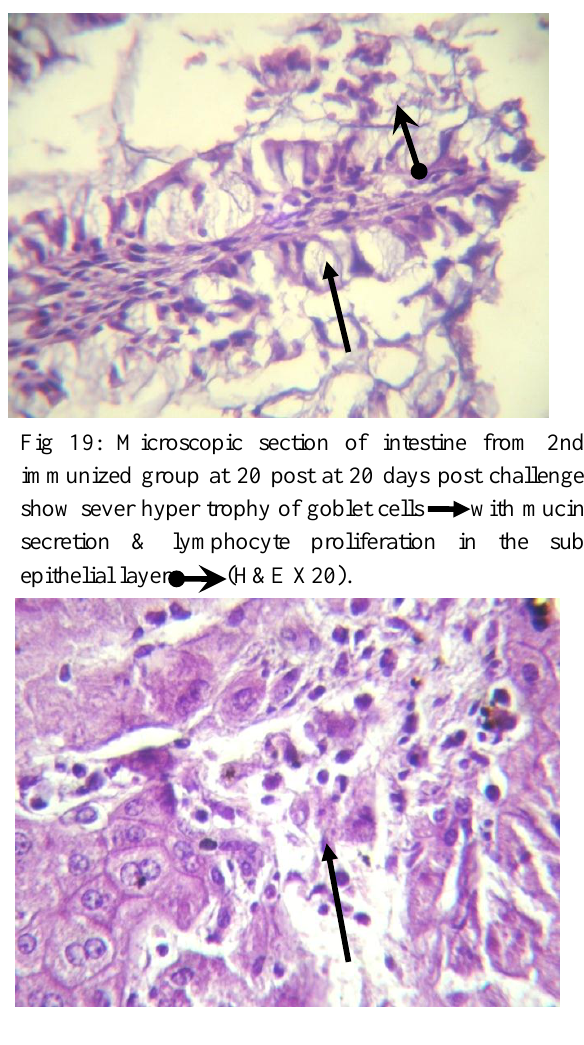
Fig 21: Microscopic lesion of liver from third group during 21-48 hrs show focal area of necrosis with PMNCS infiltration & sinusoids dilation (H&E X40).